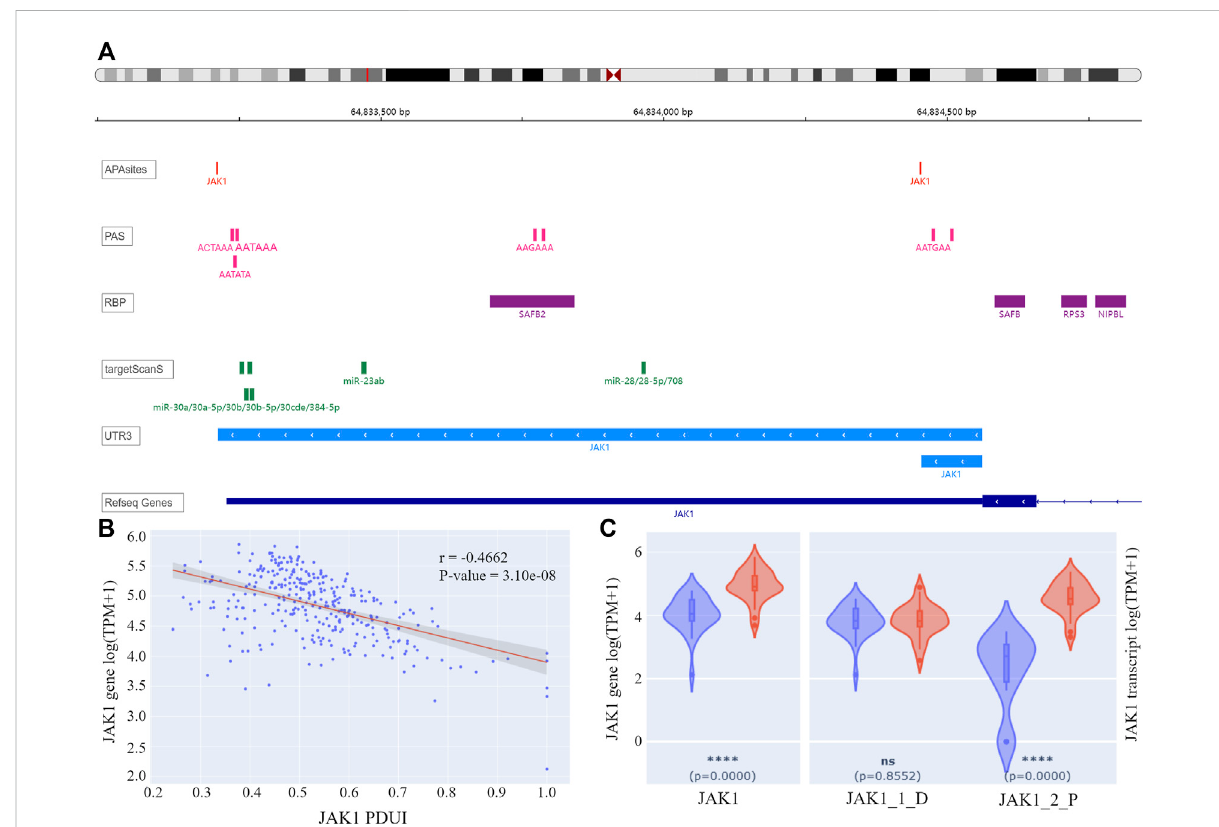
FIGURE 3 (A) IGVplot ofJAK1. The tracks from topto bottom areAPA sitesextracted from input data,PASsannotated bypolyA DB3, RBP-bindingregions annotated by ENCODE, miRNA-binding regions annotated by TargetScanHuman 7.2, 3 ′ UTR constructed by APA sites, and human genome from UCSC. (B) Correlationanalysisresult ofJAK1 PDUI and gene expression. TheX-axisrepresents PDUI of thedistalJAK1 APA site;theY-axis represents theexpressionofJAK1. Each dotin thescatter plotrepresents an APL sample. The redline is theregressioncurve, and thegrayregion shows its 95%con fi denceinterval. (C) BoxplotsofgeneandtranscriptexpressionofJAK1inthehigh-PDUIgroup(blue)andlow-PDUIgroup(red). “ JAK1_1_D ” represents the transcript with the distal APA, and “ JAK1_2_P ” represents the transcript with the proximal APA. **** p -value < 0.0001. ns p -value